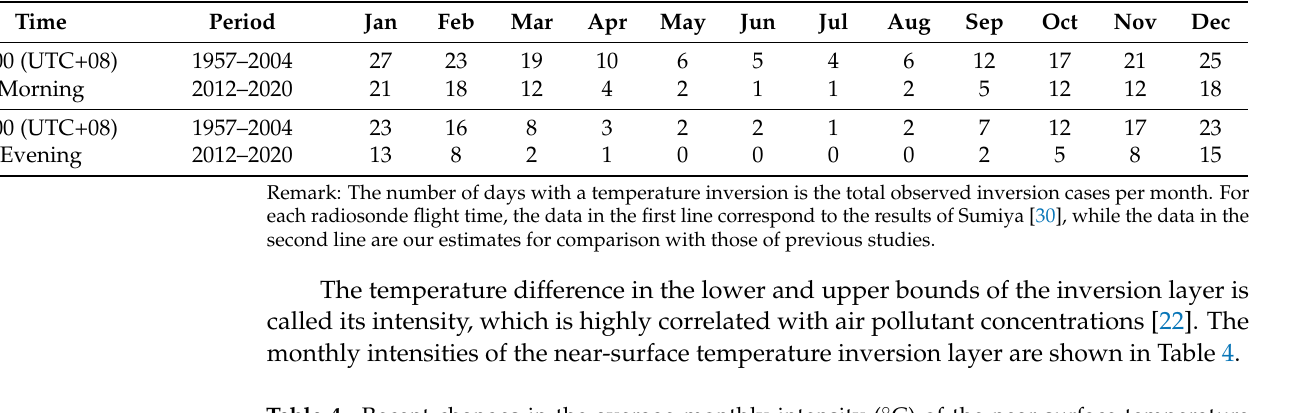
Table 4. Recent changes in the average monthly intensity ( ◦ C) of the near-surface temperature inversion over Ulaanbaatar